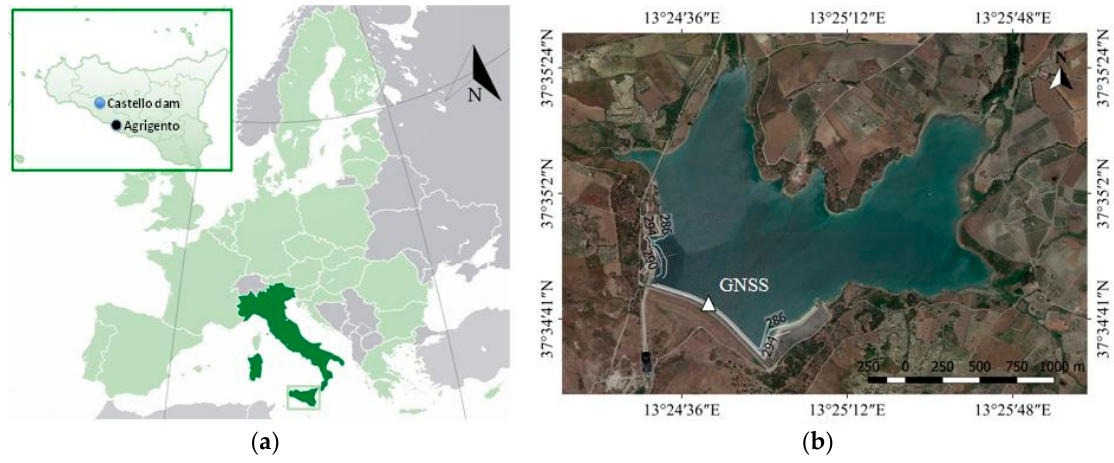
Figure 2. ( a ) Geographical position of the study area; ( b ) satellite view of the Castello dam with over imposed the GNSS reference station